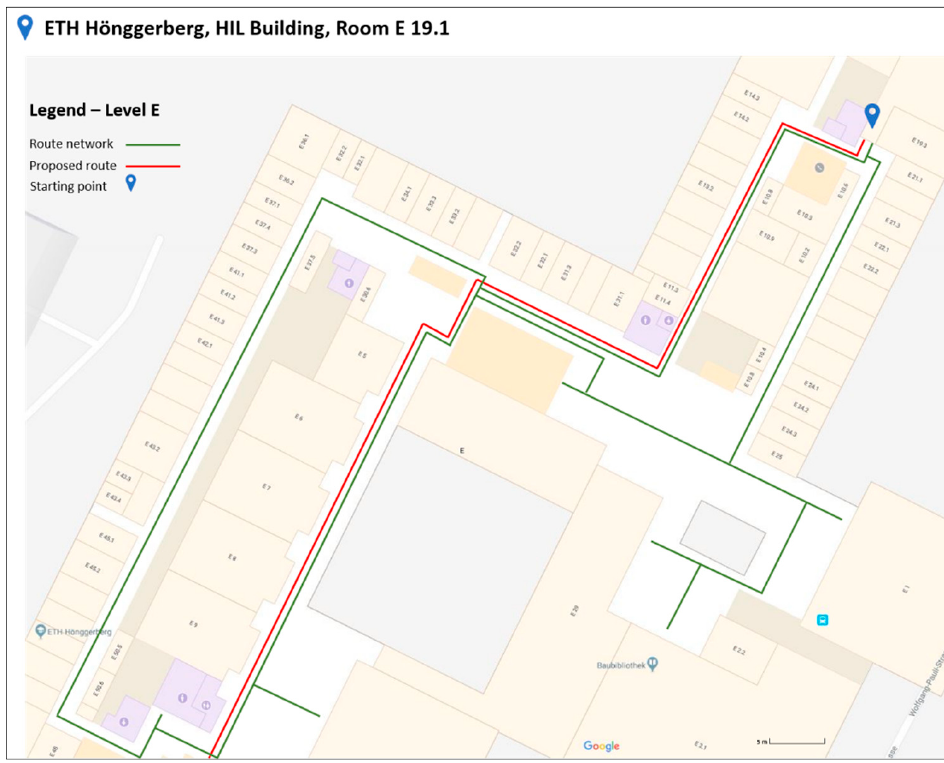
Figure 2. Starting point (room E 19.1) and routing path on the E floor. Multimodal Technol. Interact. 2019 , 2 , x FOR PEER REVIEW